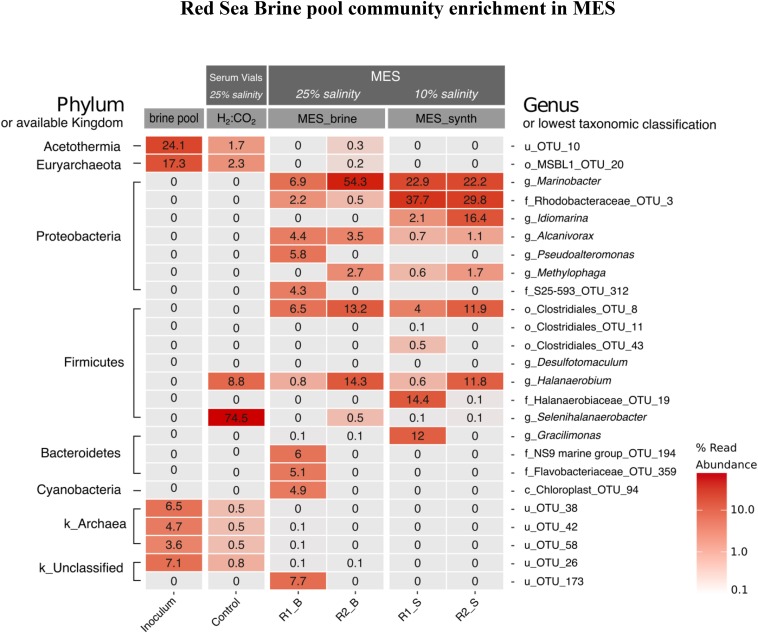
Heatmap distribution of the 25 most abundant phylotypes across all samples in phase I (see Figure 1). The taxa level shown on the left-hand side represents the phyla while on the right-hand side represents the lowest classification level possible (u: unclassified, c: class, o: order, f: family, or g: genus). The scale in the bottom right represents relative abundance (%) of reads. B refers to brine pool and S refers to synthetic saline media.